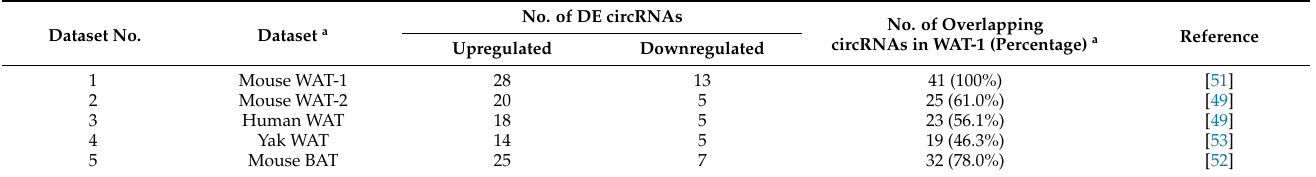
Table 2. Common circRNAs in WAT and BAT profiling datasets of different species.